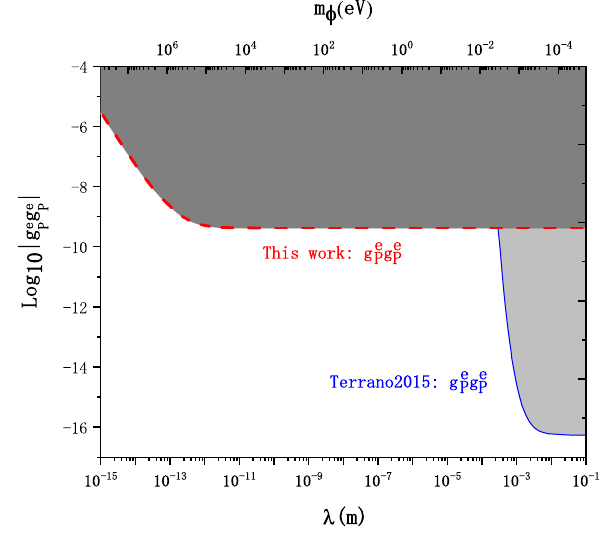
Fig. 2 A constraint to the coupling constant product | g tion of the interaction range λ (ALP mass). The (red) dashed line is the result of this work for the muon. The dark grey area is excluded from this work